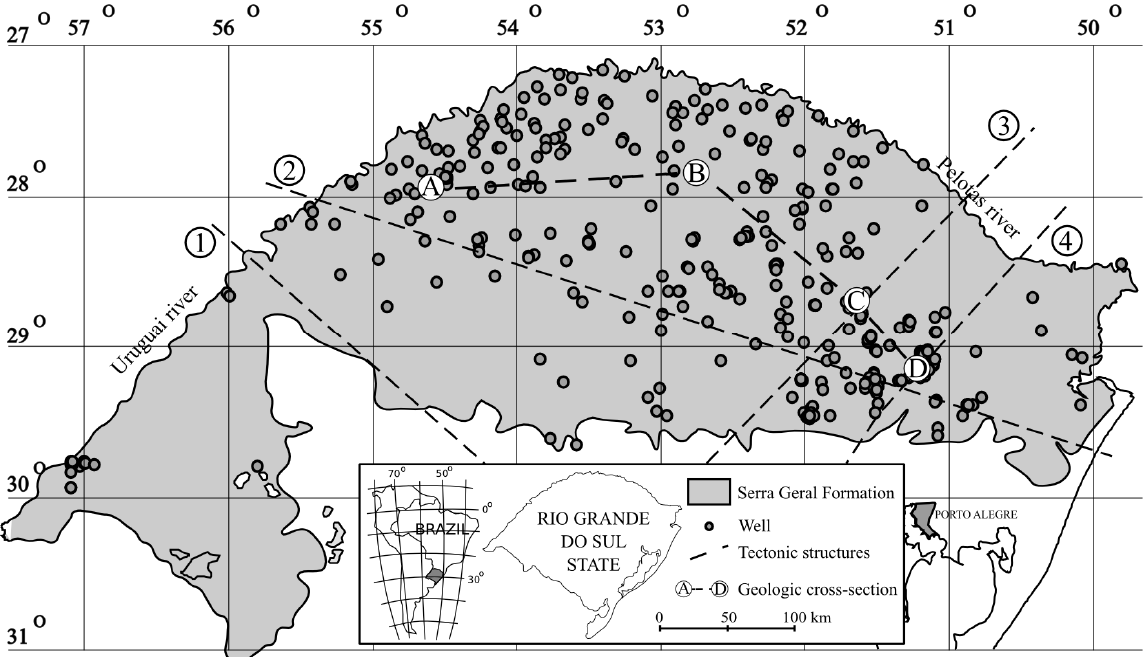
Fig. 1 – Location map of SGAS(gray) in Rio Grande do Sul State, sampling wells and main tectonic fault systems: (1) Mata-Jaguari, (2) Terra de Areia-Posadas, (3) Perimpo, and (4)